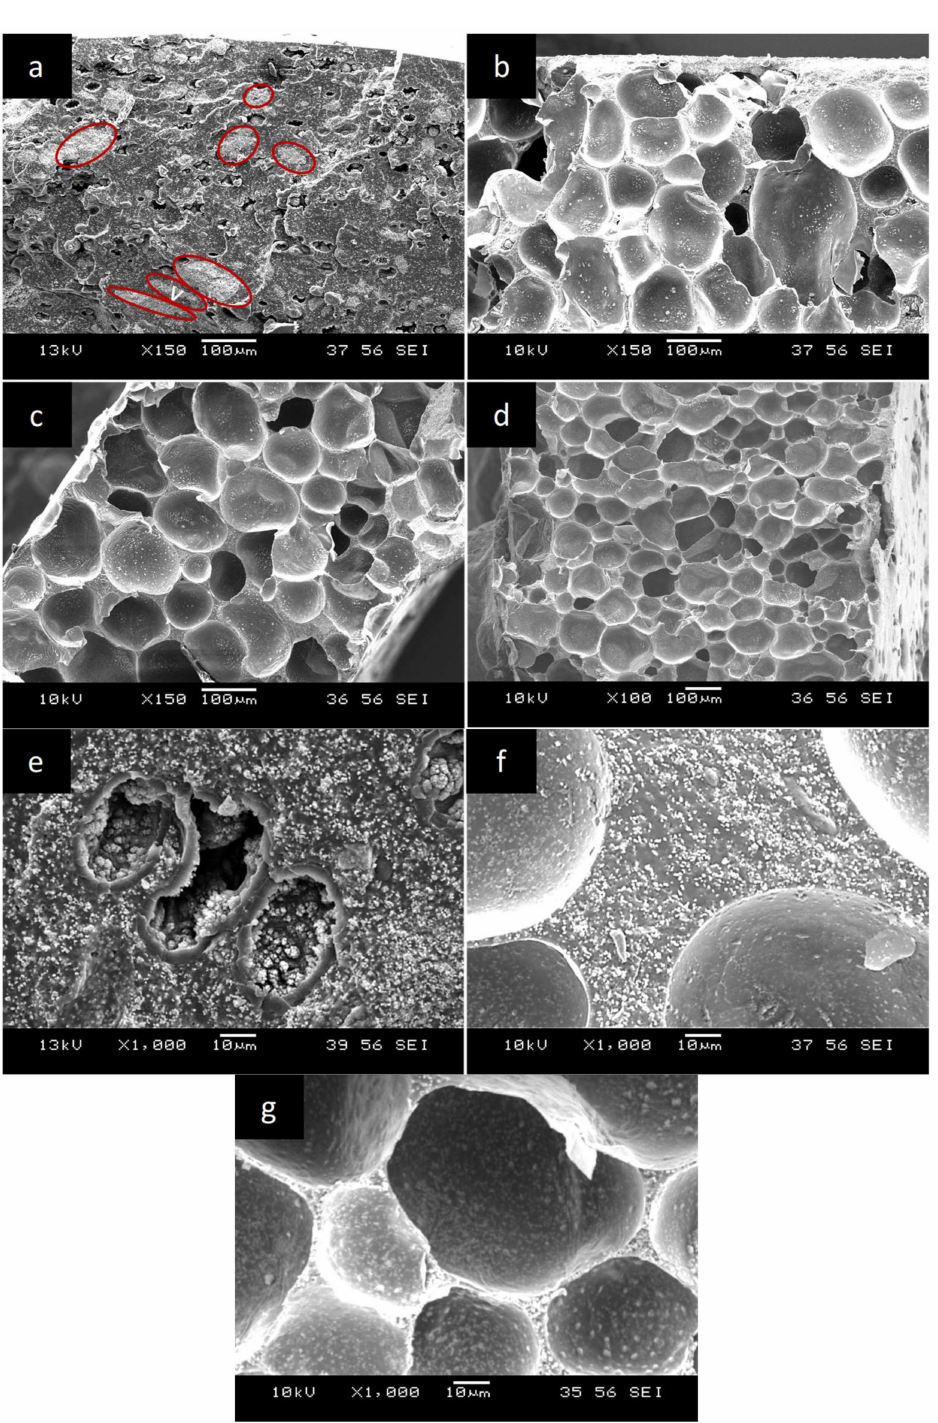
Figure 3. Cellular morphology of TPU/20 vol % PZT composite foams with ( a ) ϕ = 1 (solid), ( b ) ϕ = 2, ( c ) ϕ = 3, and ( d ) ϕ = 4. High magnification micrographs showing the dispersion of PZT in ( e ) solid, ( f ) cell struts, and ( g ) cell walls of foamed